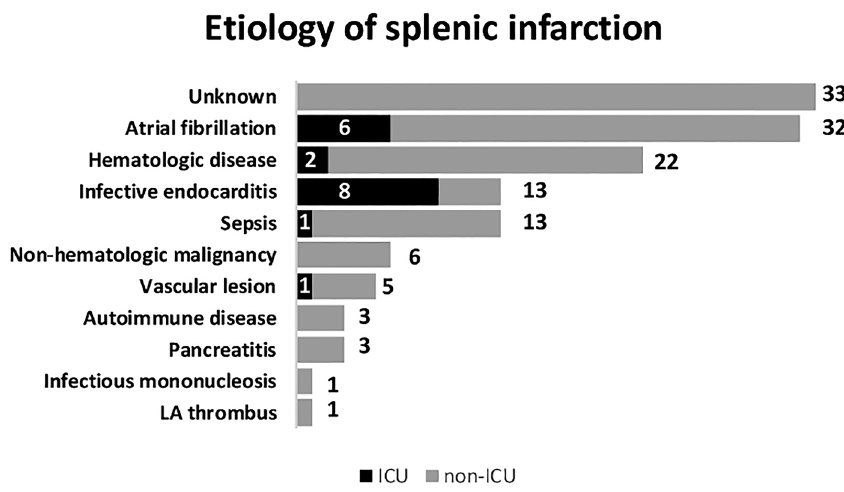
Figure 1. Illustration of the summary of case outcomes, stratified by confirmed